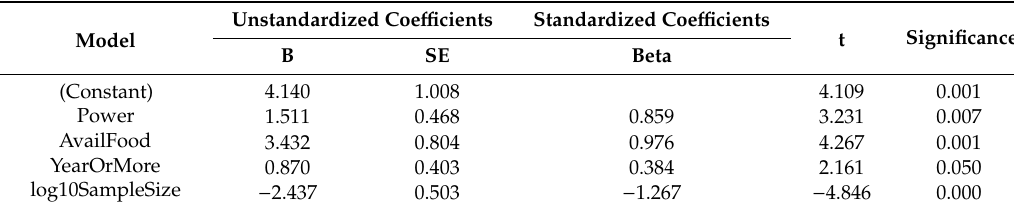
Table 6. Linear regression model for